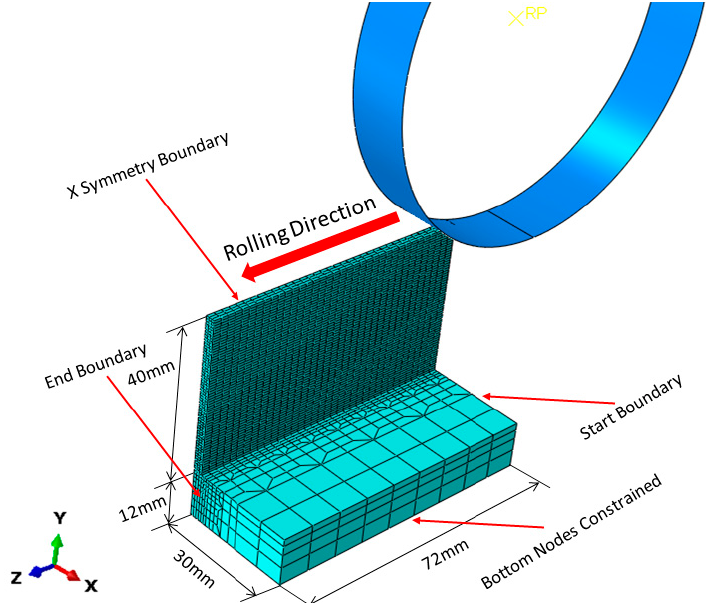
Figure 2. Short transient displacement-controlled model.